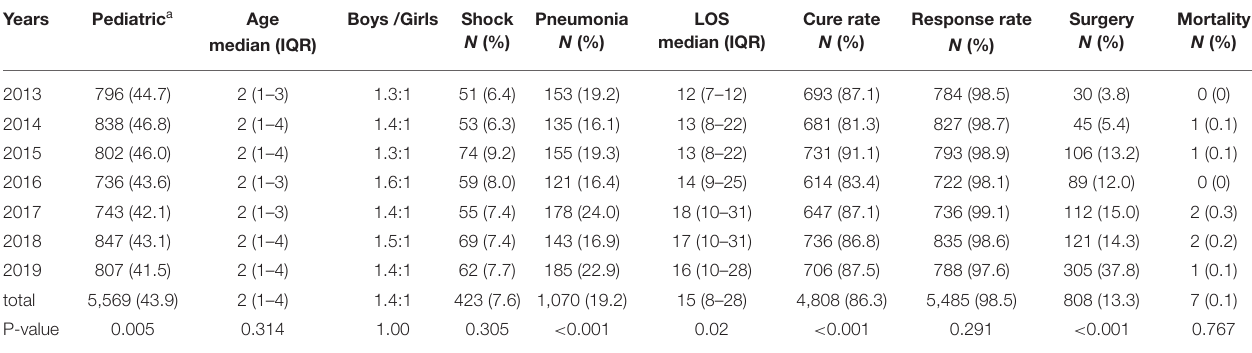
TABLE 1 | Patient characteristics from 2013 to 2019.